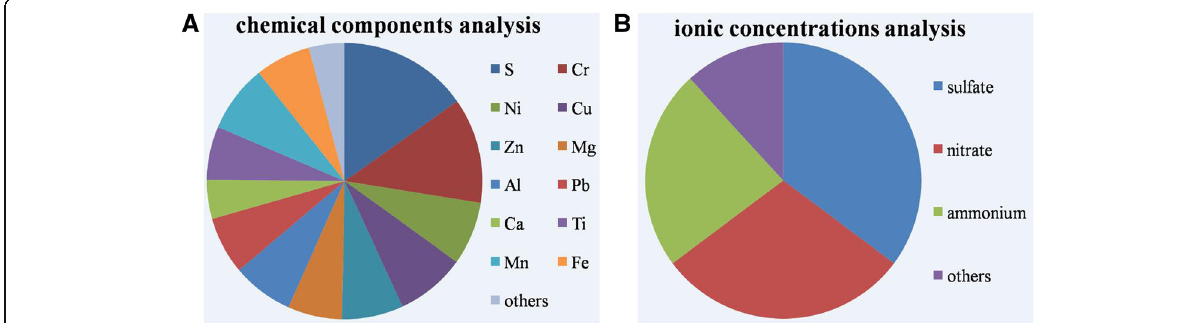
Fig. 2 PM2.5 source apportionment analysis. Chemical components were detected based on inductively coupled plasma mass spectrometry and inductively coupled plasma-atomic emission spectrometry, respectively. a Chemical components analysis. b Ionic concentrations